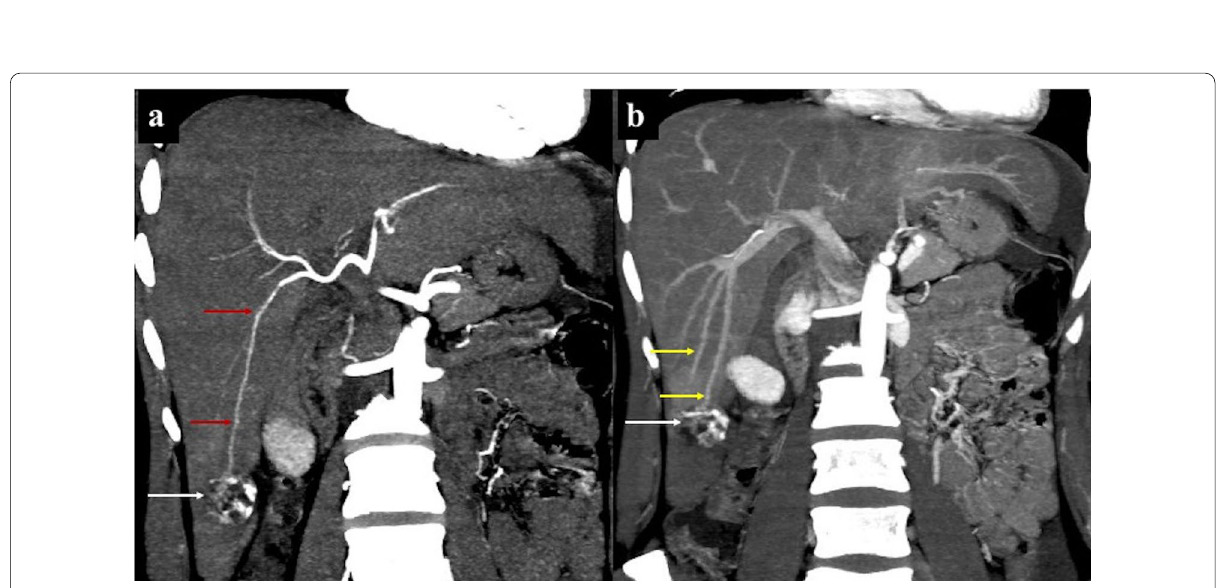
Fig. 3 ( a-b ) a Coronal contrast enhance computed tomography (CECT) arterial phase image showing gestational sac (white arrow) receiving blood supply from the posterior segmental branch of the right hepatic artery (red arrows). b Coronal CECT venous phase image showing gestational sac (white arrow) also receiving blood supply from the posterior division of the right portal vein (yellow